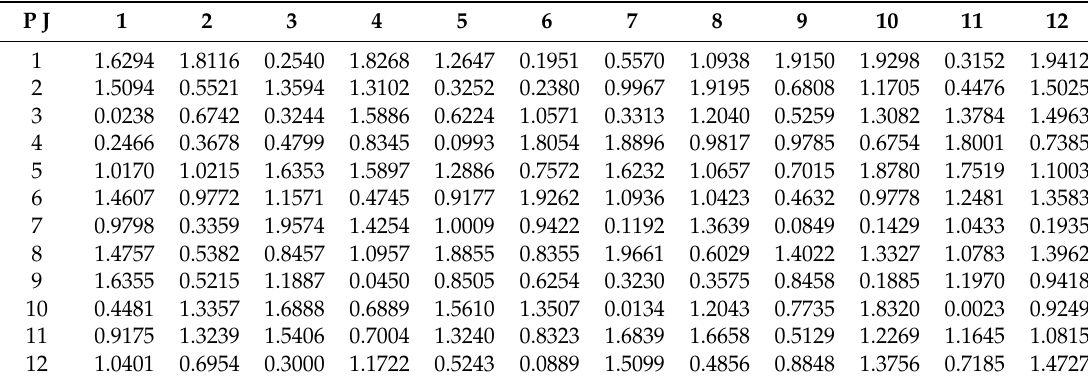
Table 12. Downtime data of some the j-th operator in the i-th job.